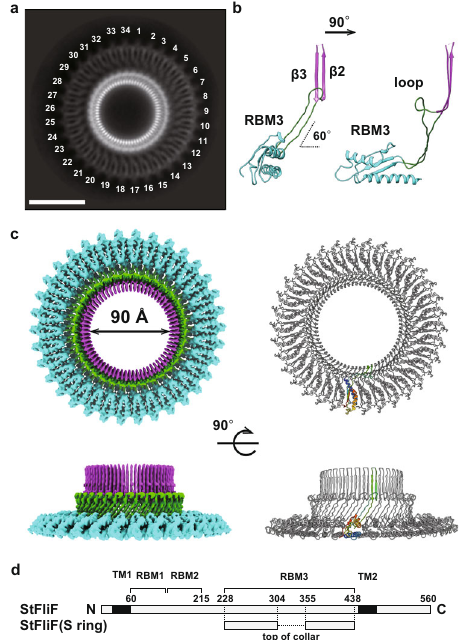
Fig. 2 Structure of the S ring and collar of the MS ring formed by full- length FliF. a A representative 2D class average image showing 34-fold symmetry. b C α ribbon representation of the RBM3 domain model forming the S ring and collar in two orthogonal side views. c CryoEM 3D image reconstruction of the S ring and collar (left) and C α ribbon diagram of the atomic model (right) in end-on (upper) and side (lower) views. d Domain organization of Salmonella FliF, indicating the region forming the S ring and collar. TM1 and TM2: transmembrane regions; numbers above the bars: residue numbers in the FliF